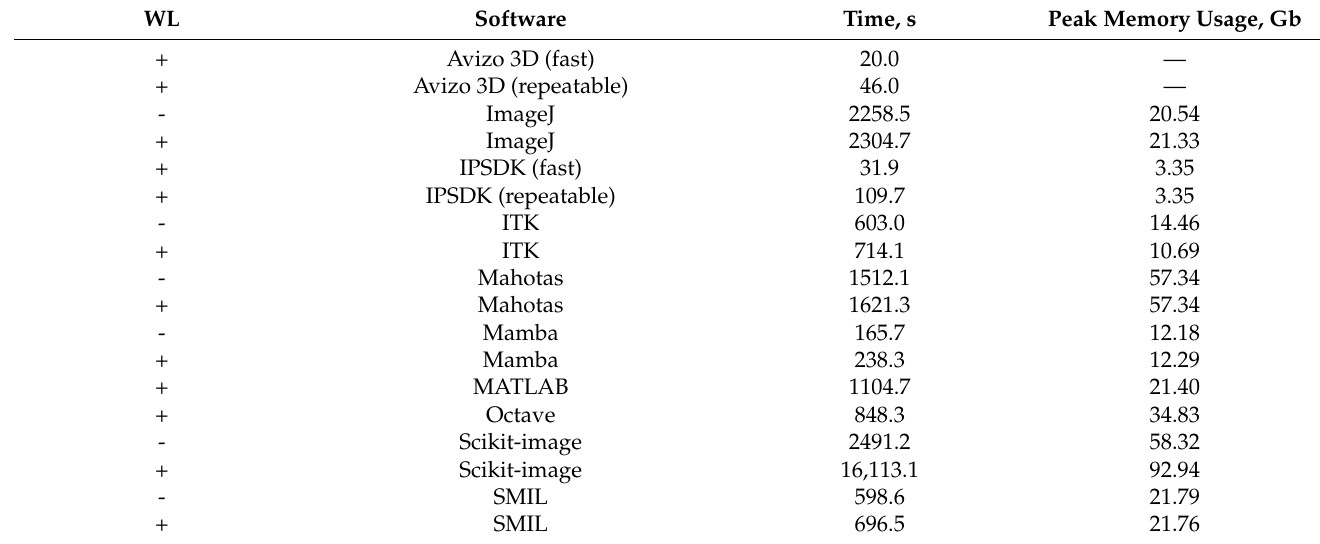
Table 4. Processing time and peak memory consumption of various watershed implementations for segmentation of an FIB-SEM image.